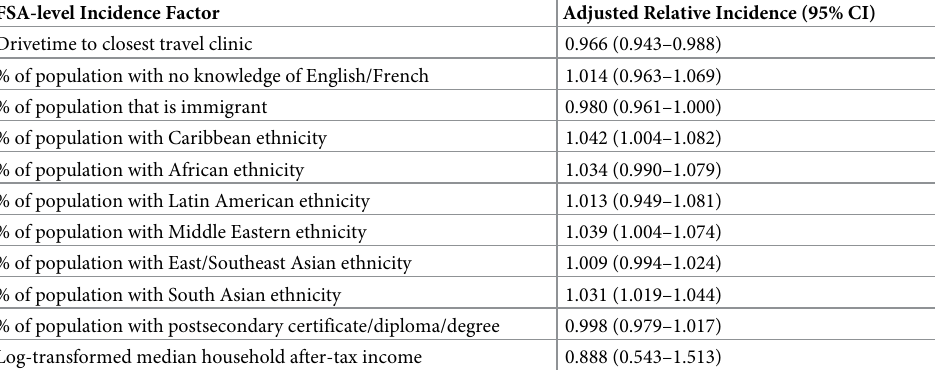
Table 1. Drivetime analysis. Adjusted Bayesian hierarchical model estimates for the association between drivetime to closest travel clinic and forward sortation area (FSA)-level travel-acquired infection burden within the Greater Toronto